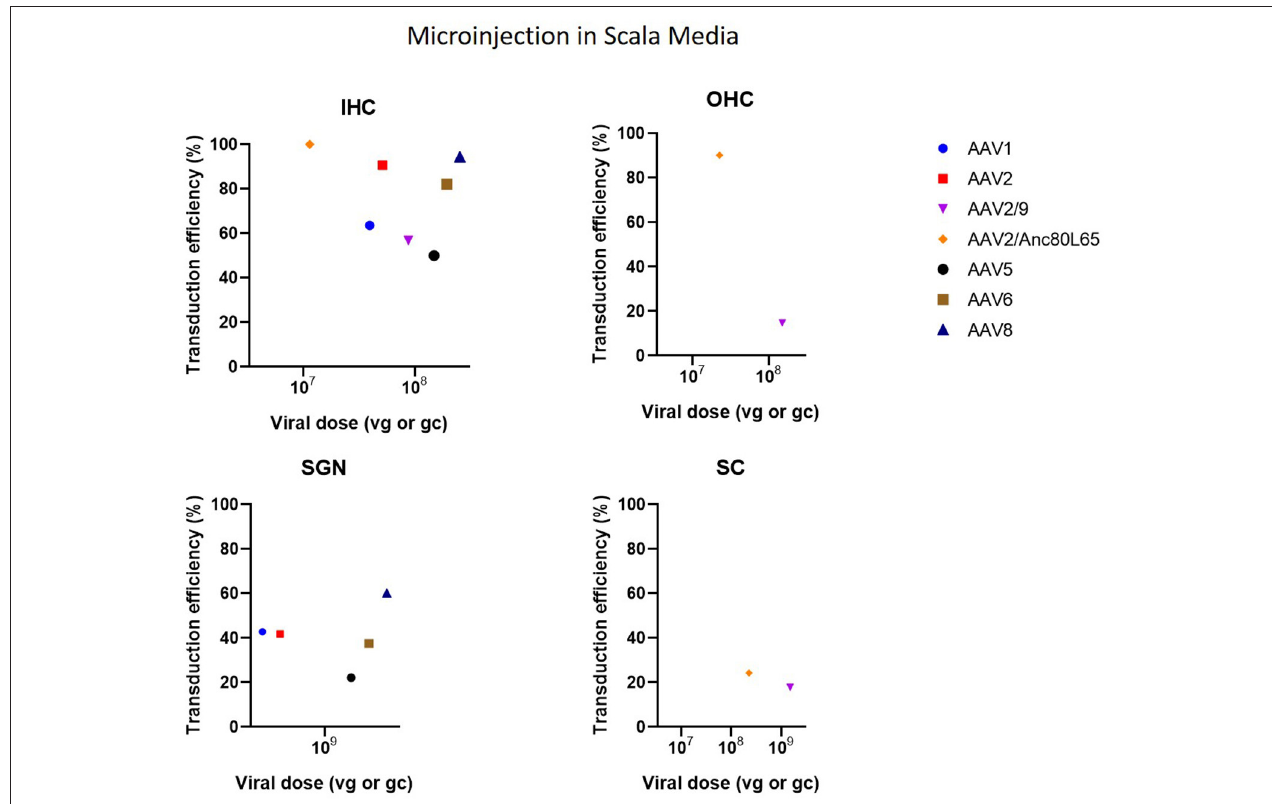
FIGURE 6 | Transduction efficiency of IHC, OHC, SGN and SC according to viral vector dose using microinjection in the scala media. Only data from studies that performed inner ear application of AAV in mice were used to plot these graphs. IHC, inner hair cell; OHC, outer hair cell; SGN, spiral ganglion neuron; SC, supporting cell in organ of Corti; AAV, adeno-associated vector; gc, genome copies; vg, viral genomes.